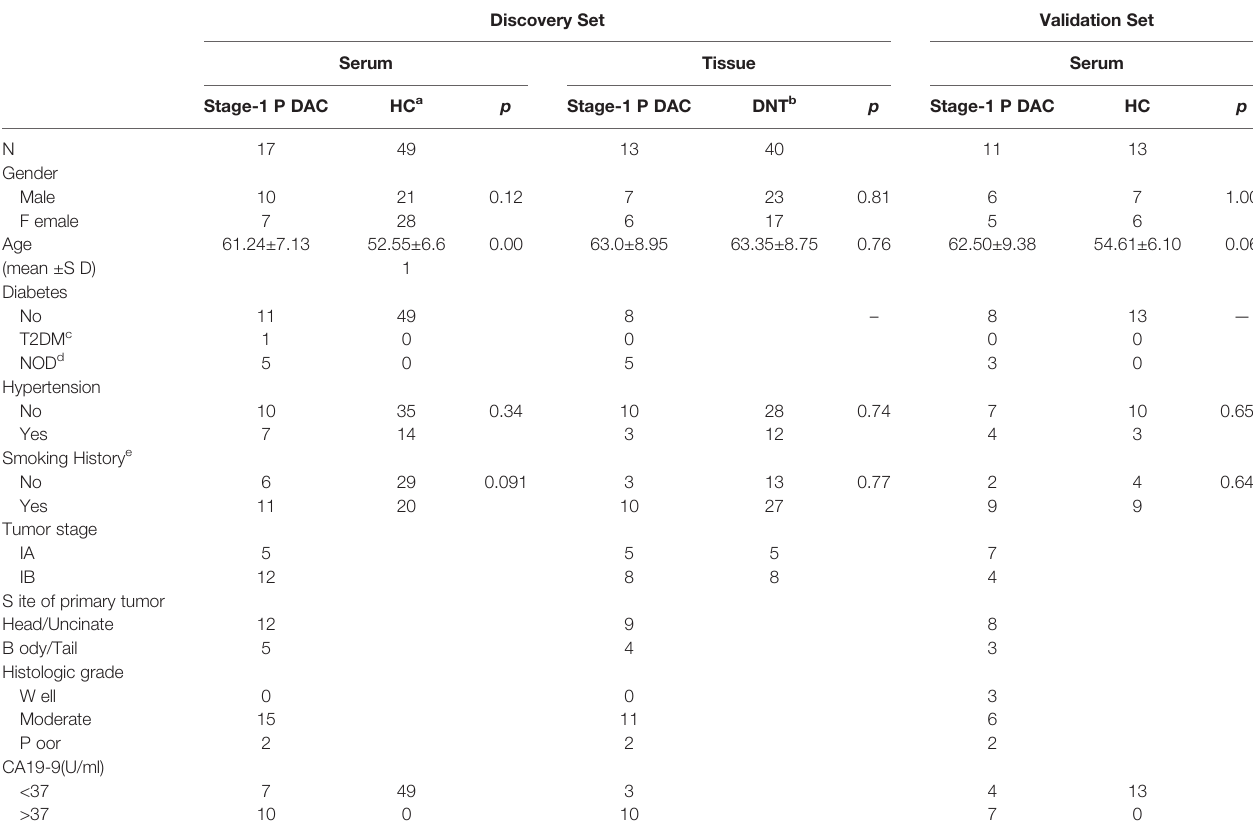
TABLE 1 | Clinical characteristics of patients with stage-I pancreatic cancer and healthy controls in training and validation